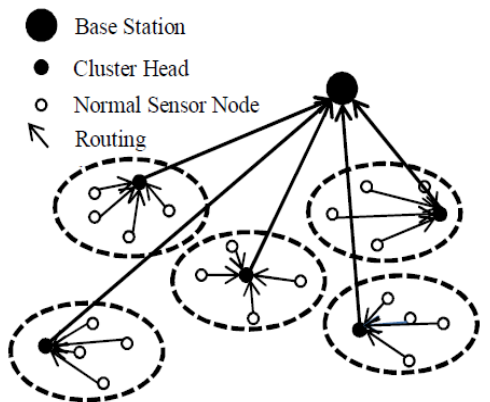
Figure 1. Clustering network